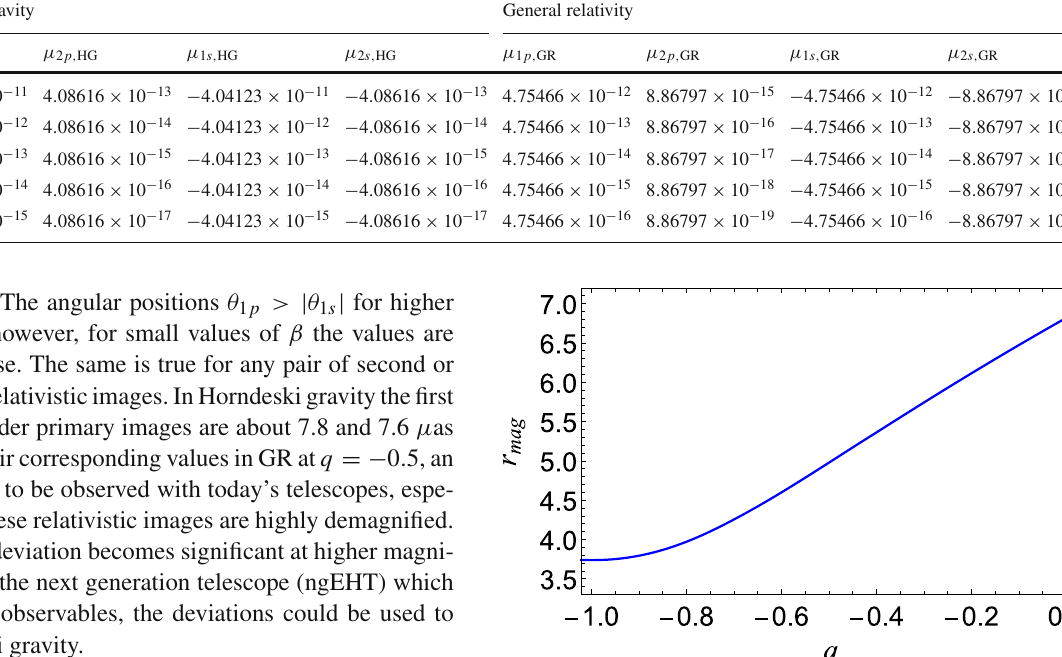
as primary and secondary images, respectively. (b) We have used M first order relativistic images in GR and Horndeski Gravity are, respec- β . (a) tively, θ General relativity